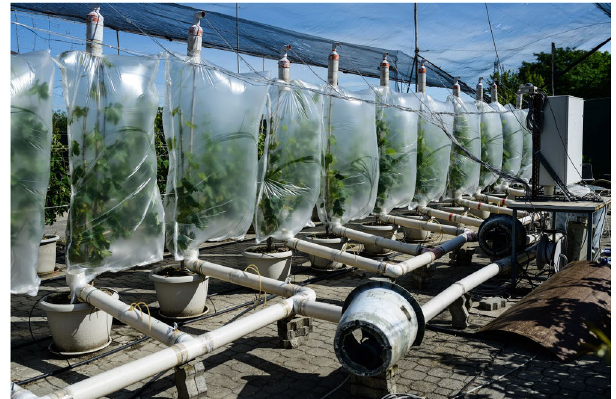
Figure 1. General view of the whole-canopy gas exchange system set up at the beginning of